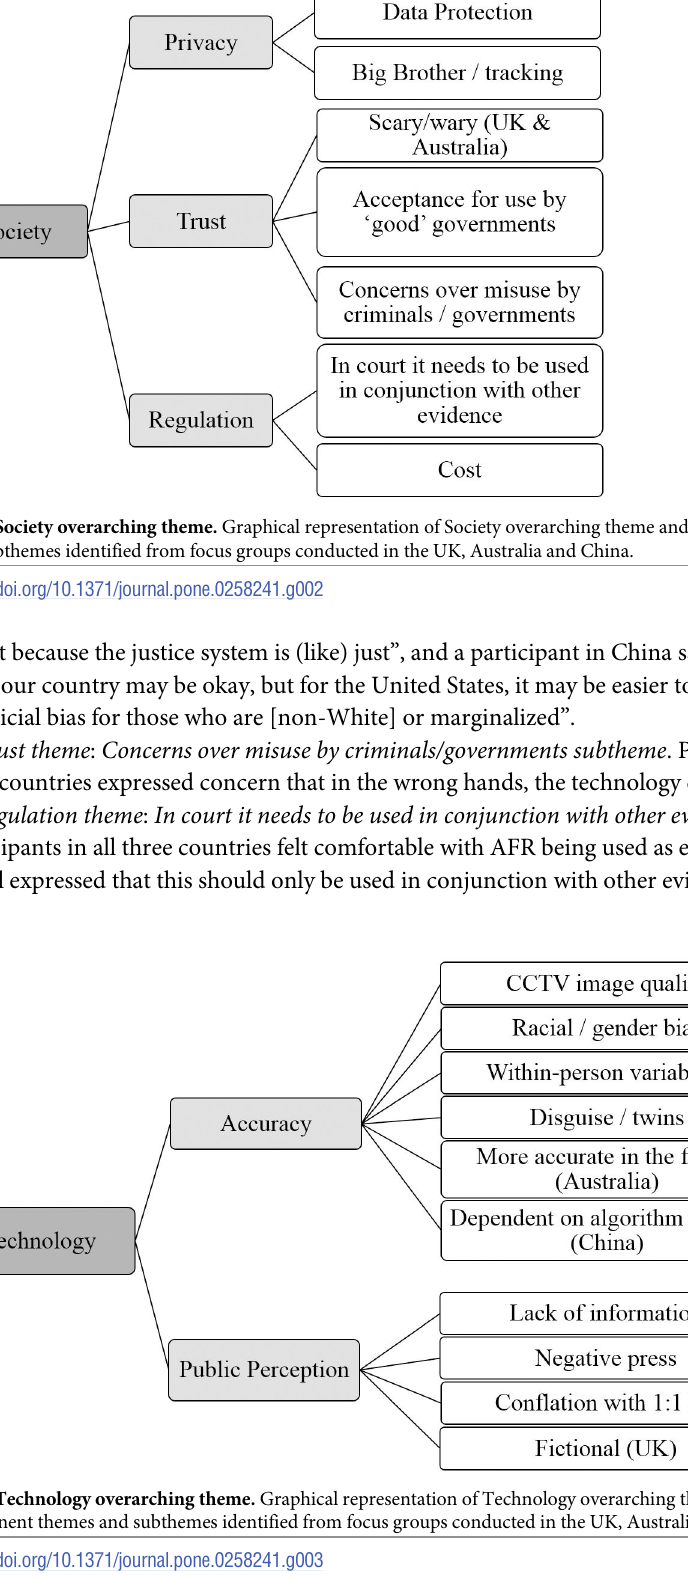
PLOS ONE | https://doi.org/10.1371/journal.pone.0258241 October 13,